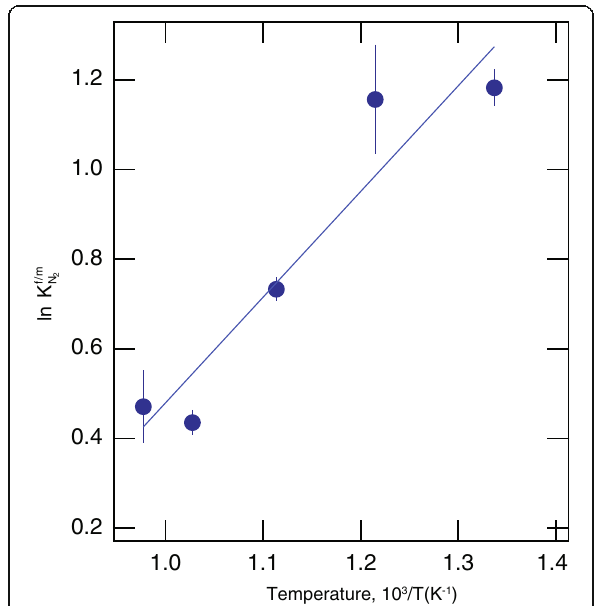
Fig. 16 Partition coefficient between fluid and melt of N 2 , K N2f/m , as a function of temperature. The least squares straight line fit is, K H2Of/m = − 1.9 ± 0.5 + 2356 ± 450/T, r 2 =